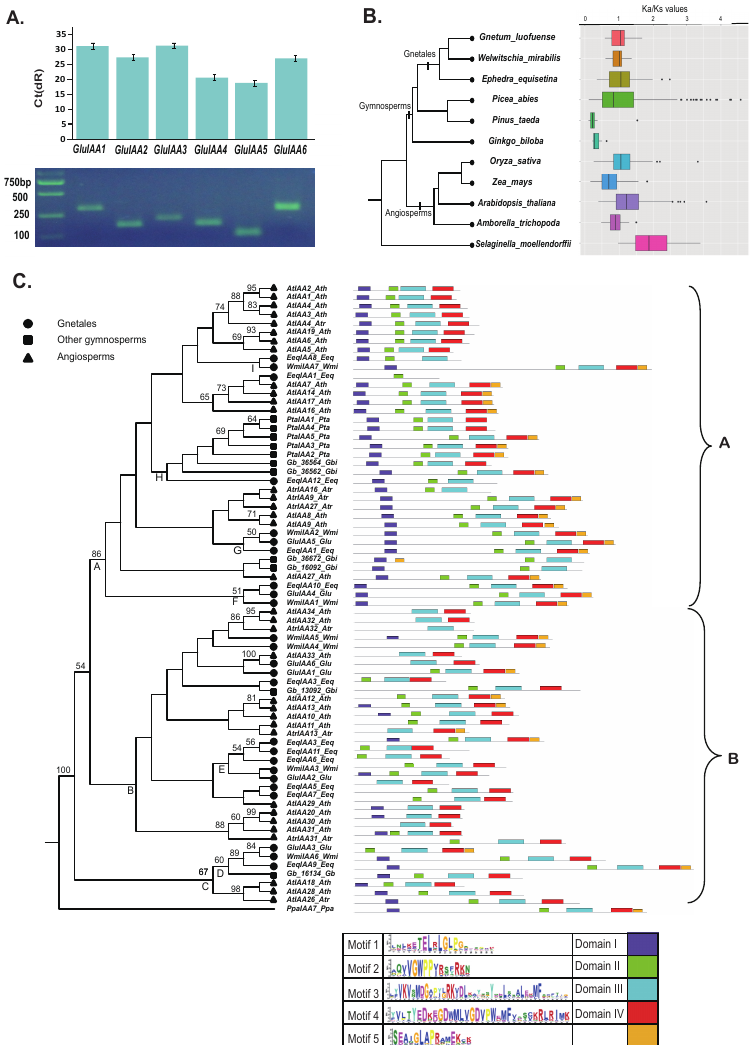
Figure 6. ( A ) The expression of six Aux / IAA genes from G. luofuense verified by qRT-PCR; the relative expression values normalized with the ∆∆ Ct-method are presented, above and qRT-PCR products were exhibited by gel electrophoresis, as shown below; ( B ) Molecular evolutionary rates of Aux / IAAs represented by paralogous gene pairs of Ka / Ks values in 11 land plant species; ( C ) Phylogenetic relationship among canonical Aux / IAA genes for seed plants (left), and varied types of structures examined (right) and the content of conservative amino acids, corresponding to five motifs and four conservative domains, i.e., Domains I–IV, was expressed by the height of characters